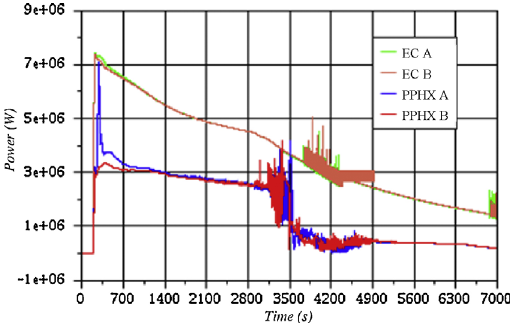
Fig. 23. Emergency heat removal by ECs and PPHXs (W).